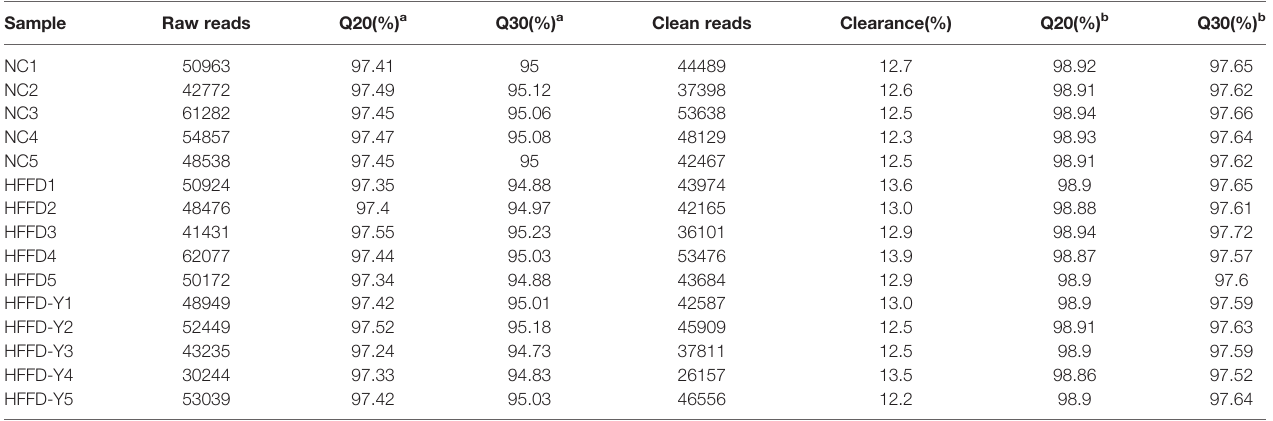
TABLE 4 | Sequencing data control